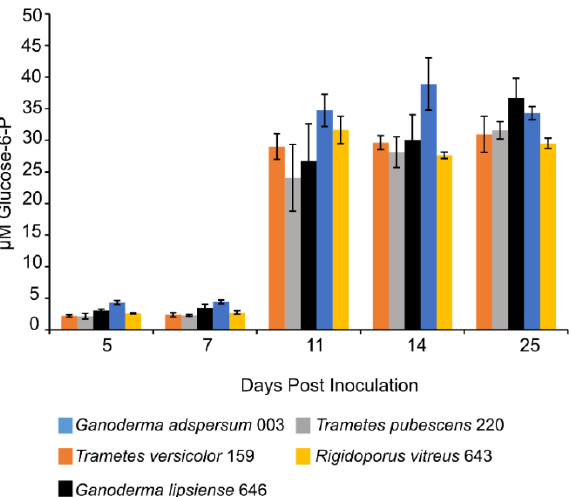
Figure 5. Glucose-6-P concentration at different days of incubation period of various white rot fungi when incubated with 2% ( w/v ) malt extract and TEMPO-oxidized CNF(0.017 wt%) and CNC(0.2 wt%) at 25 °C and 80% relative humidity. Cultures were initially shaken to stimulate growth but after 2 days they were left to stand for the dura- tion of the experiment. Data represent an average of three biological replicates. biological